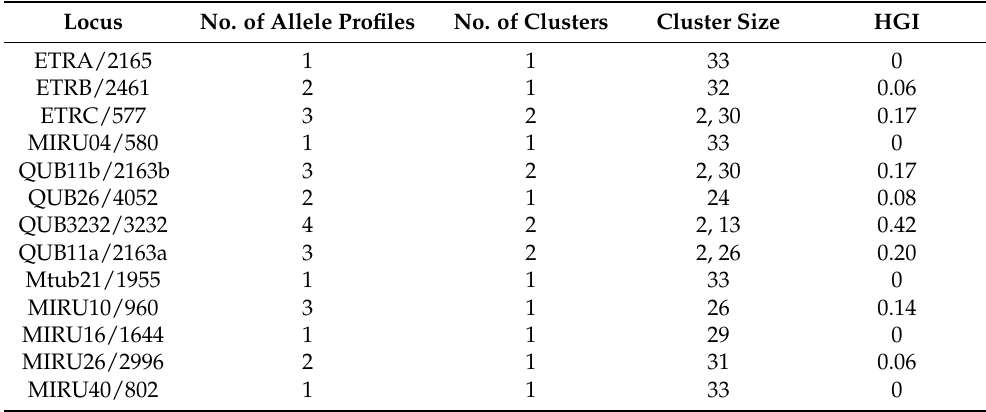
Table 2. Diversity of VNTR loci in M. caprae isolates from Bulgaria. Locus No. of Allele Profiles No. of Clusters Cluster Size